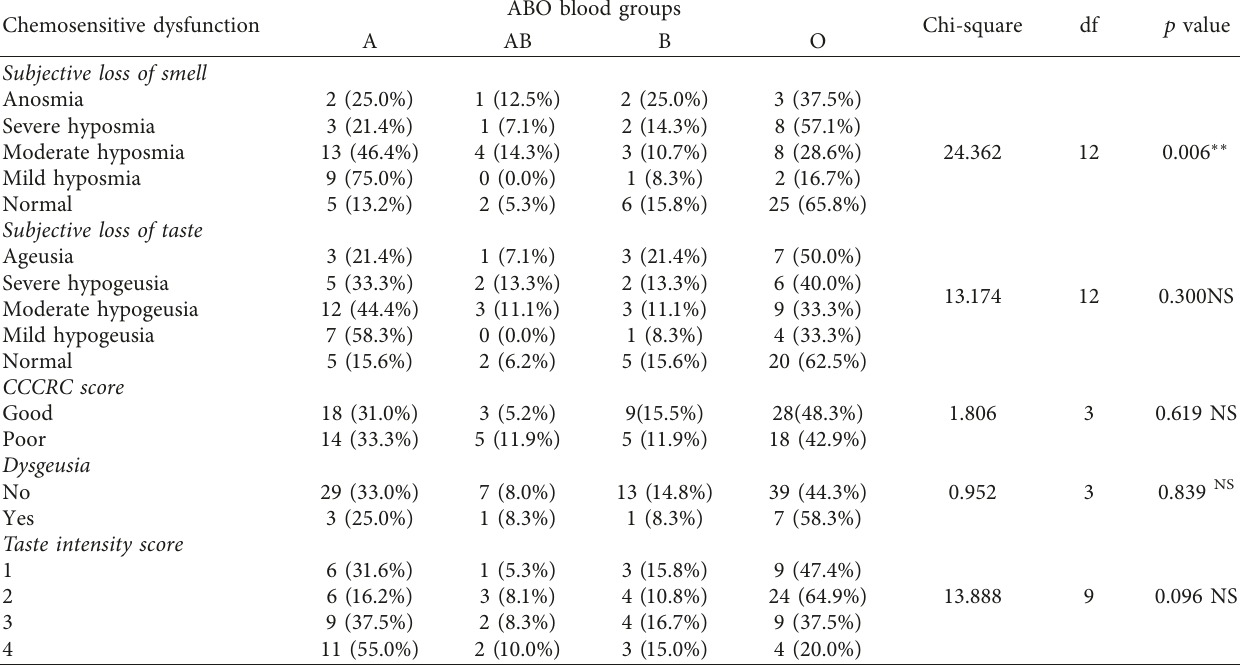
Table 3: Chi-square test of association between ABO blood groups and chronic chemosensitive dysfunction in post- COVID-19 patients (fishers exact